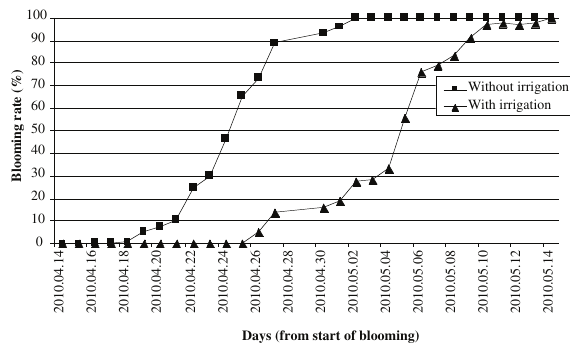
Figure 7. The effect of irrigation on the blooming dynamic of pear. Between April 14 and May 14,